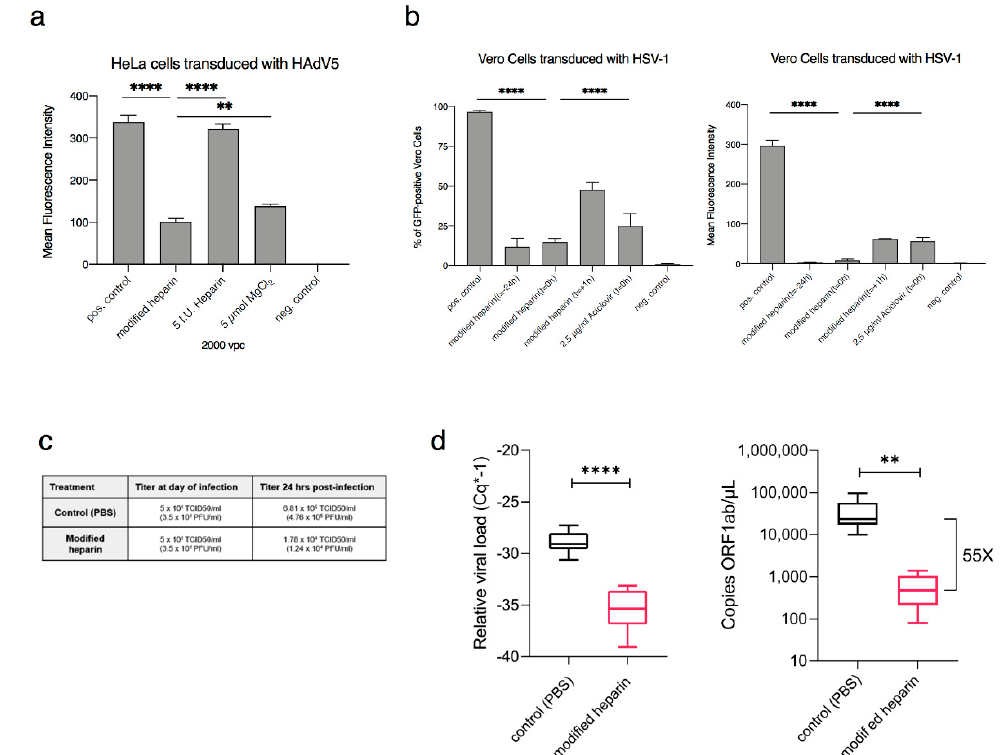
Figure 3. Antiviral effect of modified heparin: ( a ) Modified heparin inhibits virus transduction of human adenovirus 5 (HAdV5) in HeLa cells. The mean fluorescent intensity (MFI) shows significantly lower transduction efficiencies after treatment with modified heparin compared to untreated control. For statistical analyses one-way ANOVA was performed, displayed are means + standard deviation. ** p -values ≤ 0.005; **** p -values ≤ 0.00005; ( b ) Measurements of herpes simplex virus-1 (HSV-1) on Vero cells showed decreased transduction efficiencies after treatment with heparin/MgCl 2 at different time points: t = − 24 h (24 h before transduction), t = 0 h (at the time point of transduction) and t = +1 h (1 h after transduction). As control we compared the results with aciclovir treated cells ( t = 0 h). Percentage of GFP-positive cells and mean fluorescent intensity (MFI) are displayed. For statistical analyses one-way ANOVA was performed, displayed are means + standard deviation. **** p -values ≤ 0.00005. pos. control: untreated virus; neg. control: cells without